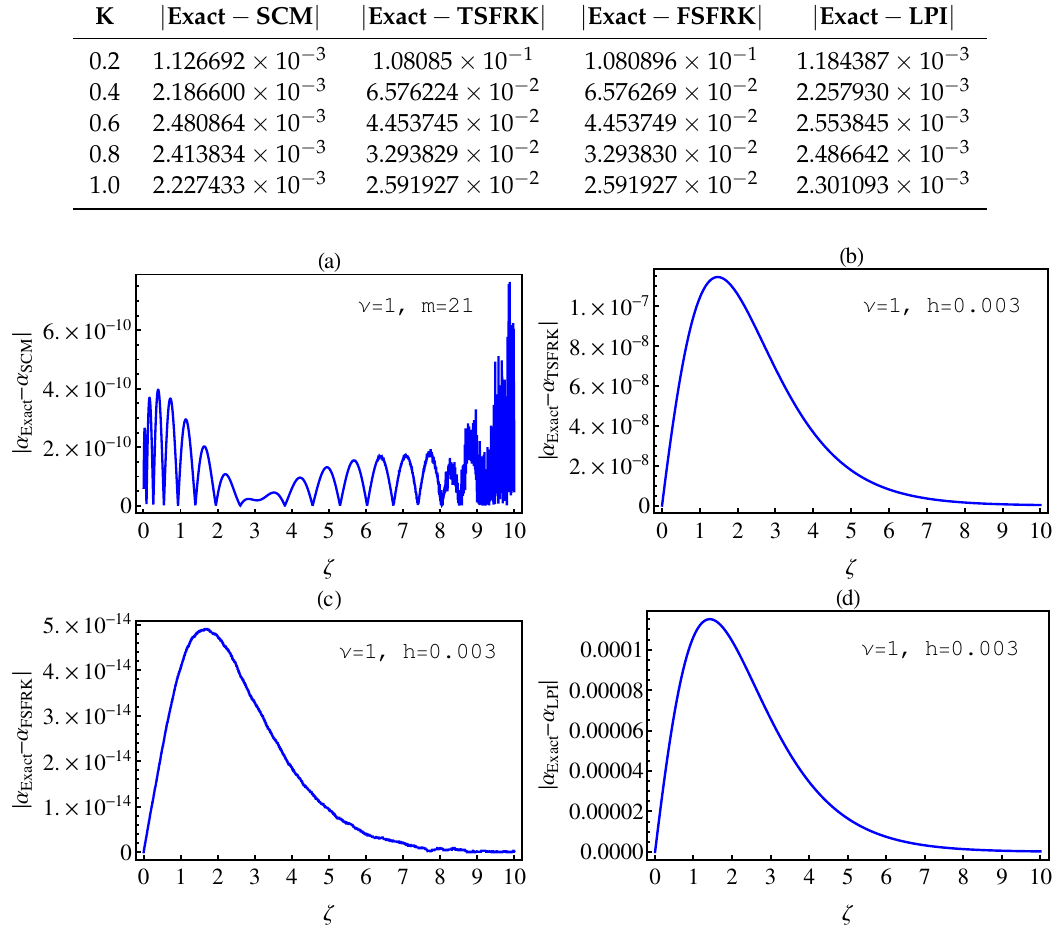
Figure 1. The absolute error between the exact and the numerical solutions of (6) based upon SCM ( a ); TSFRK ( b ); FSFRK ( c ) and LPI ( d ), respectively, for ν = 1.0, h = 0.03, m = 21, K = 1.0, α ( 0 ) =